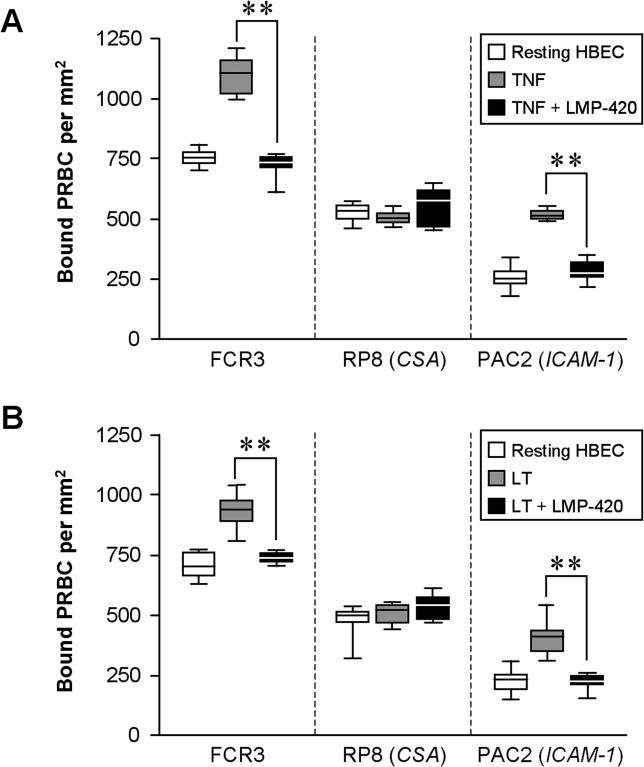
LMP-420 Inhibits TNF- and LT-Induced Increase of PRBC CytoadherenceHBEC-5i were cultured until confluence was reached and were left resting or activated as described earlier. Cytoadherence assays were then performed with FCR3-P. falciparum strain, and RP8 and PAC2 subpopulations selected for their ability to bind only CSA and ICAM-1/CD36, respectively (A and B). Results of six determinations in five experiments are expressed in bound PRBC, after two washing steps after the assay (Dunn's test, ** corresponds to p < 0.01).